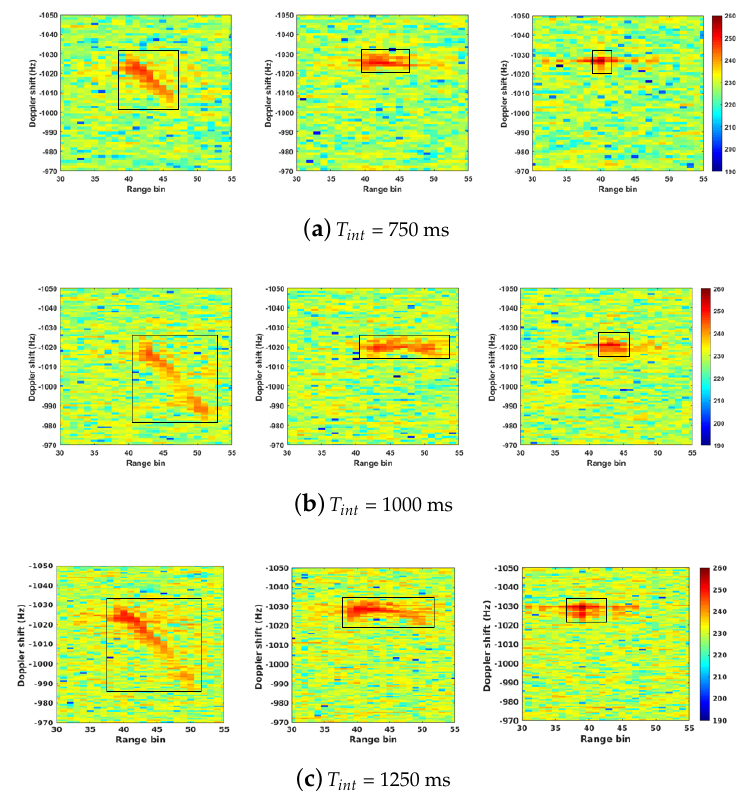
Figure 17. Target motion compensation results in the CAF zoomed area with different integration times. Left, center, and right images are inputs, outputs of second stage, and outputs of third stage of the proposed scheme.